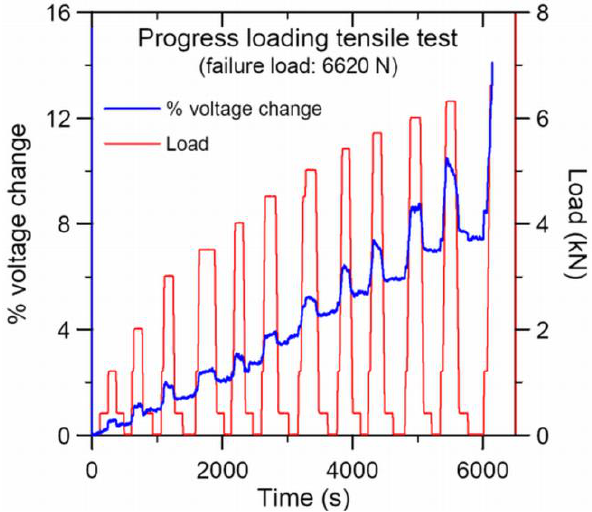
Figure 4. Load-free spectra measured after progressively loading up to 6300 N (~95% of failure load) in a typical tensile specimen.